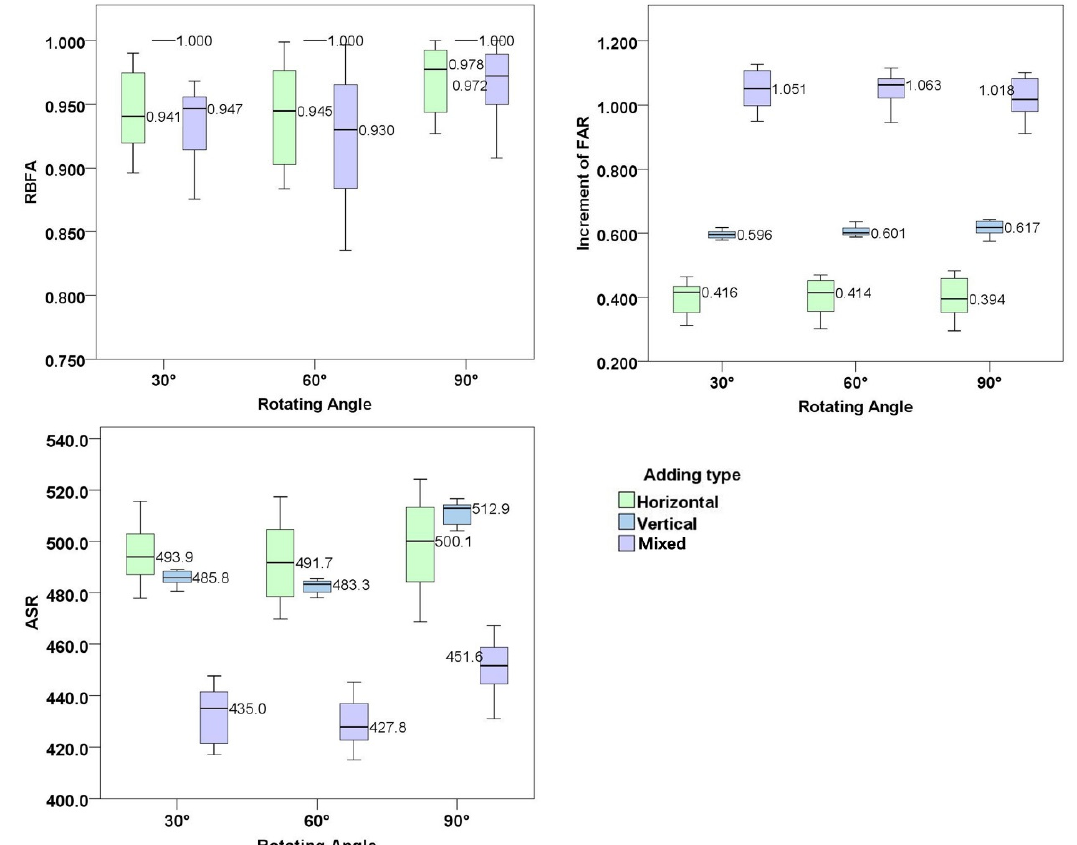
Figure 14. Objective values of the three addition modes for the varied orientations.